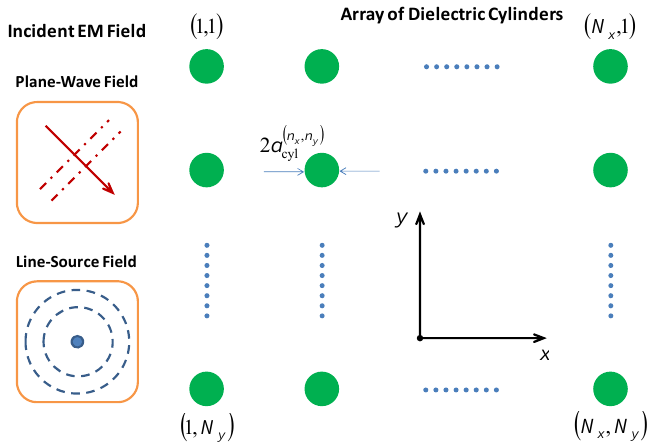
Figure 1. An arbitrarily large, rectangular array of circular dielectric cylinders, excited by either a plane ‐ wave field or by an infinite line source parallel to their axes. Non ‐ uniform lattices of cylinders can be readily constructed by removing certain cylinders and leaving their positions empty. Non ‐ orthogonal lattices of cylinders are possible by letting their centers be arbitrarily located.